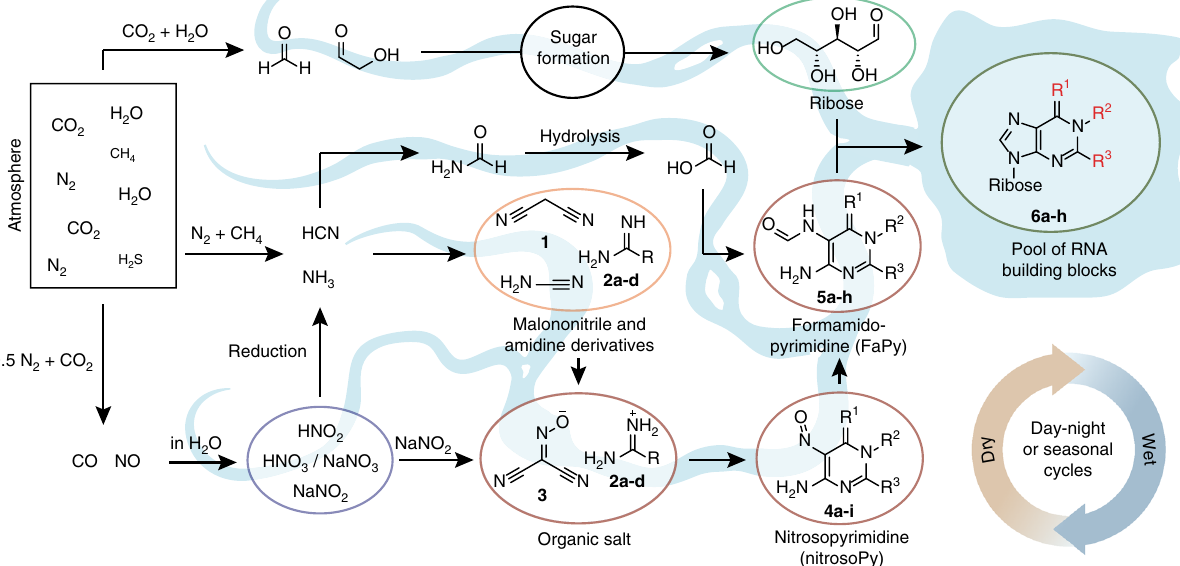
Fig. 1 RNA nucleoside formation pathway. A geothermal environment provides the right set up for the depicted transformations by establishing wet – dry cycles. The prebiotic starting materials are produced from a prebiotic atmosphere and washed into an aqueous environment (e.g. by rain). Major atmospheric components are written in larger letters, whereas minor components are written in smaller letters. Transformations are taking place in different environments, illustrated by various rivers (in light blue). Each environment provides the right setup for different chemistries, leading to several different chemical transformations. This geochemical setup leads to a set of canonical and non-canonical RNA building blocks by continuous synthesis ( 6a , m 1 G: R 1 = O, R 2 = Me, R 3 = NH 2 ; 6b , ms 2 A: R 1 = NH, R 2 = H, R 3 = SMe; 6c , A: R 1 = NH, R 2 = H, R 3 = H; 6d , m 2 G: R 1 = O, R 2 = H, R 3 = NHMe; 6e , m 2 2 G: R 1 = O, R 2 = H, R 3 = N(Me) 2 ; 6f , G: R 1 = O, R 2 = H, R 3 = NH 2 ; 6g , DA: R 1 = NH, R 2 = H, R 3 = NH 2 ; 6h , m 2 A: R 1 = NH, R 2 = H, R 3 =